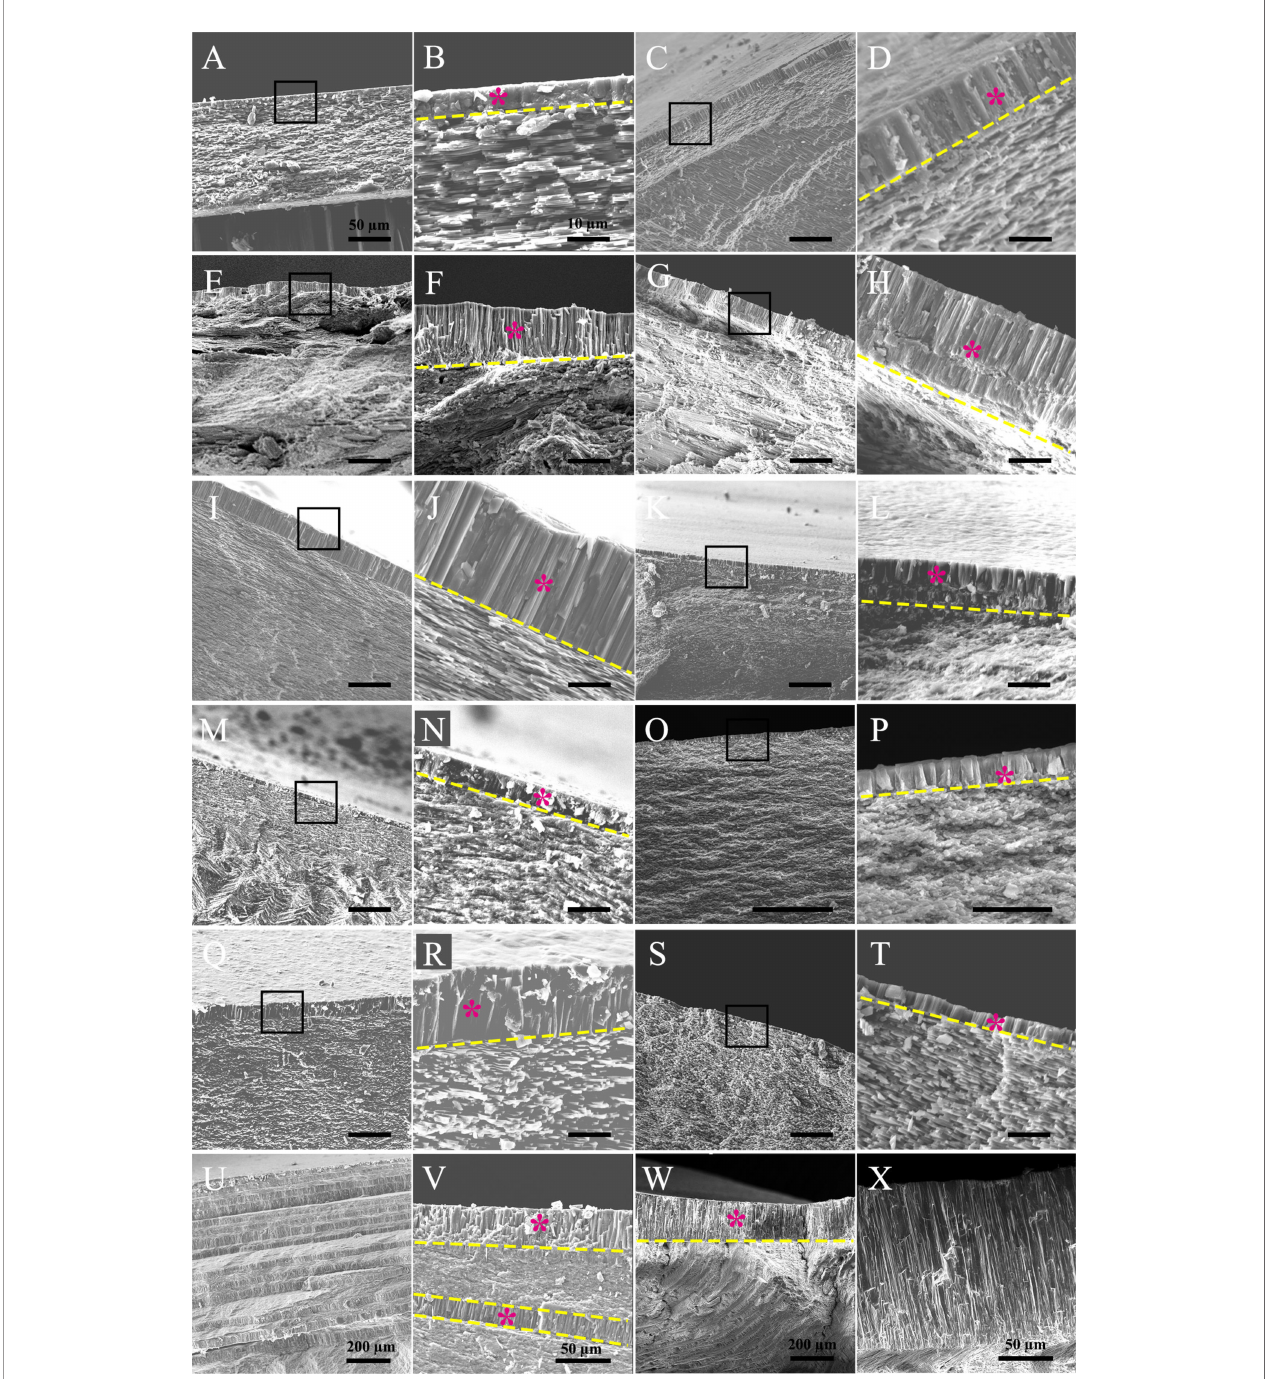
FIGURE 1 | Microstructure of the myostracum layer in bivalve molluscs. (A, B) pen shell Pinna rudis ; (C, D) mussel Mytilus edulis ; (E, F) Paci fi c oyster Crassostrea gigas ; (G, H) scallop Chlamys farreri ; (I, J) pearl oyster Pinctada fucata ; (K, L) Dosiniinae Dosinorbis japonica ; (M, N) solen Sinonovacula constricta (Lamarck); (O, P) clam Ruditapes philippinarum ; (Q, R) freshwater mussel Cristaria plicata ; (S, T) freshwater mussel Hyriopsis cumingii ; (U, V) geoduck Panopea abrupta ; (W, X) ark shell Tegillarca granosa . In each sample, the latter image is the magni fi cation of the former (black boxes), except that in (U – X) , different positions of myostracum layers are shown. The myostracum layer is indicated by a purple star, and the boundary between the myostracum and the underlying shell layers is indicated by the yellow dashed line. The scale bar is 50 µm in the former image of each sample and 10 µm in the latter (magni fi cation) as shown in (A, B) , except (U – X) which are marked in the